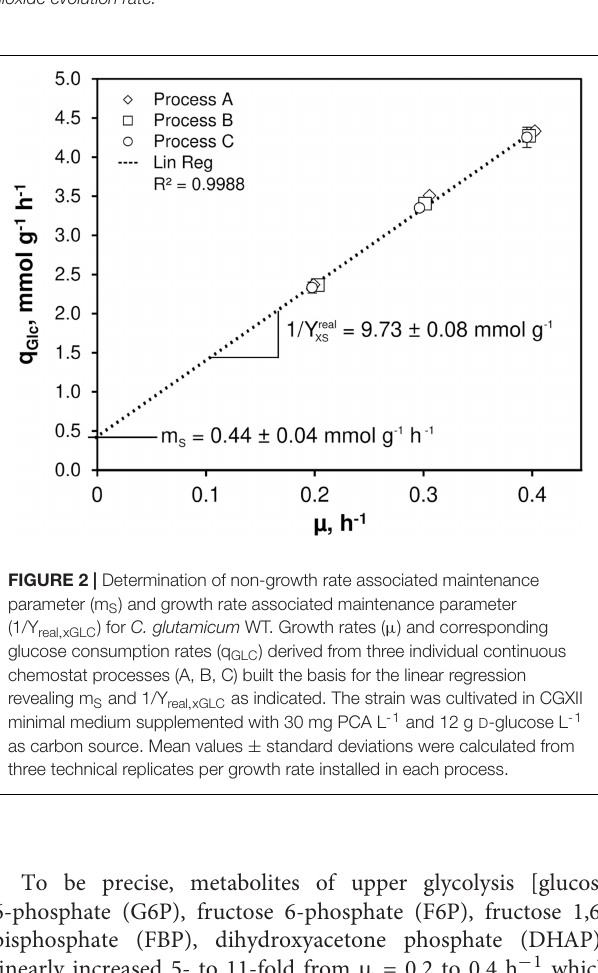
FIGURE 1 | Process parameters of triplicate chemostats (A–C) with C. glutamicum WT: dissolved oxygen ( pO 2 ), off-gas molar oxygen ( y O2 ) and carbon dioxide ( y CO2 ), biomass concentration (black diamonds). The dilution rate ( D ) was set to 0.2, 0.3, and 0.4 h - 1 and sampling was performed after five residence times. Stirrer speed and aeration remained at 700 min - 1 and 0.67 vvm, respectively. Depicted standard deviations of biomass measurements were calculated from three technical replicates per sample.